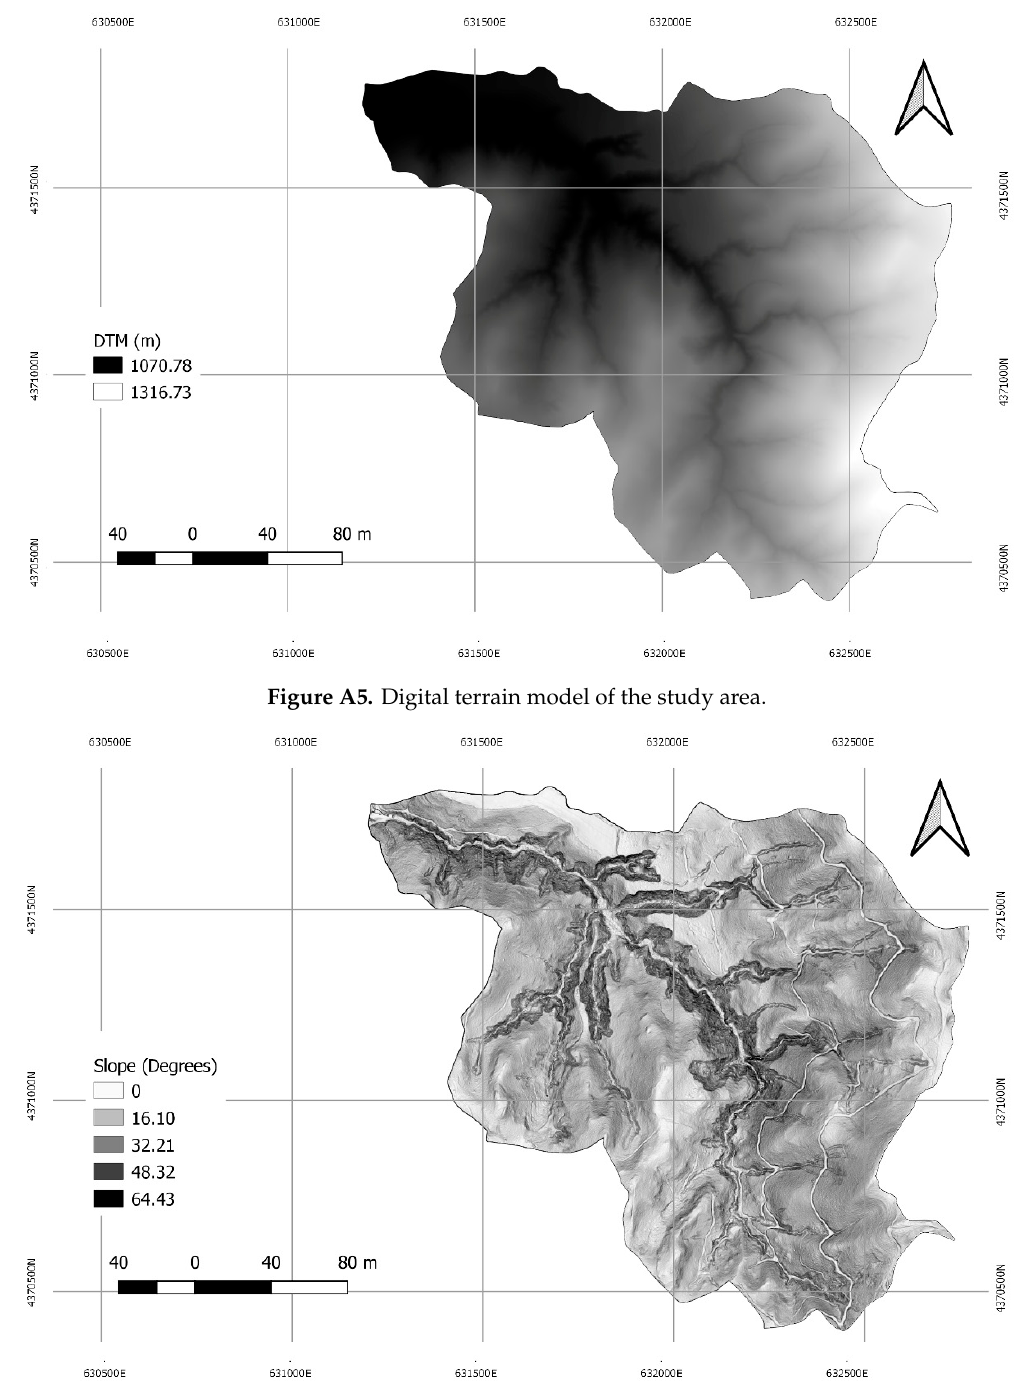
Figure A6. Slope map of the study Figure S6. Slope map of the study area